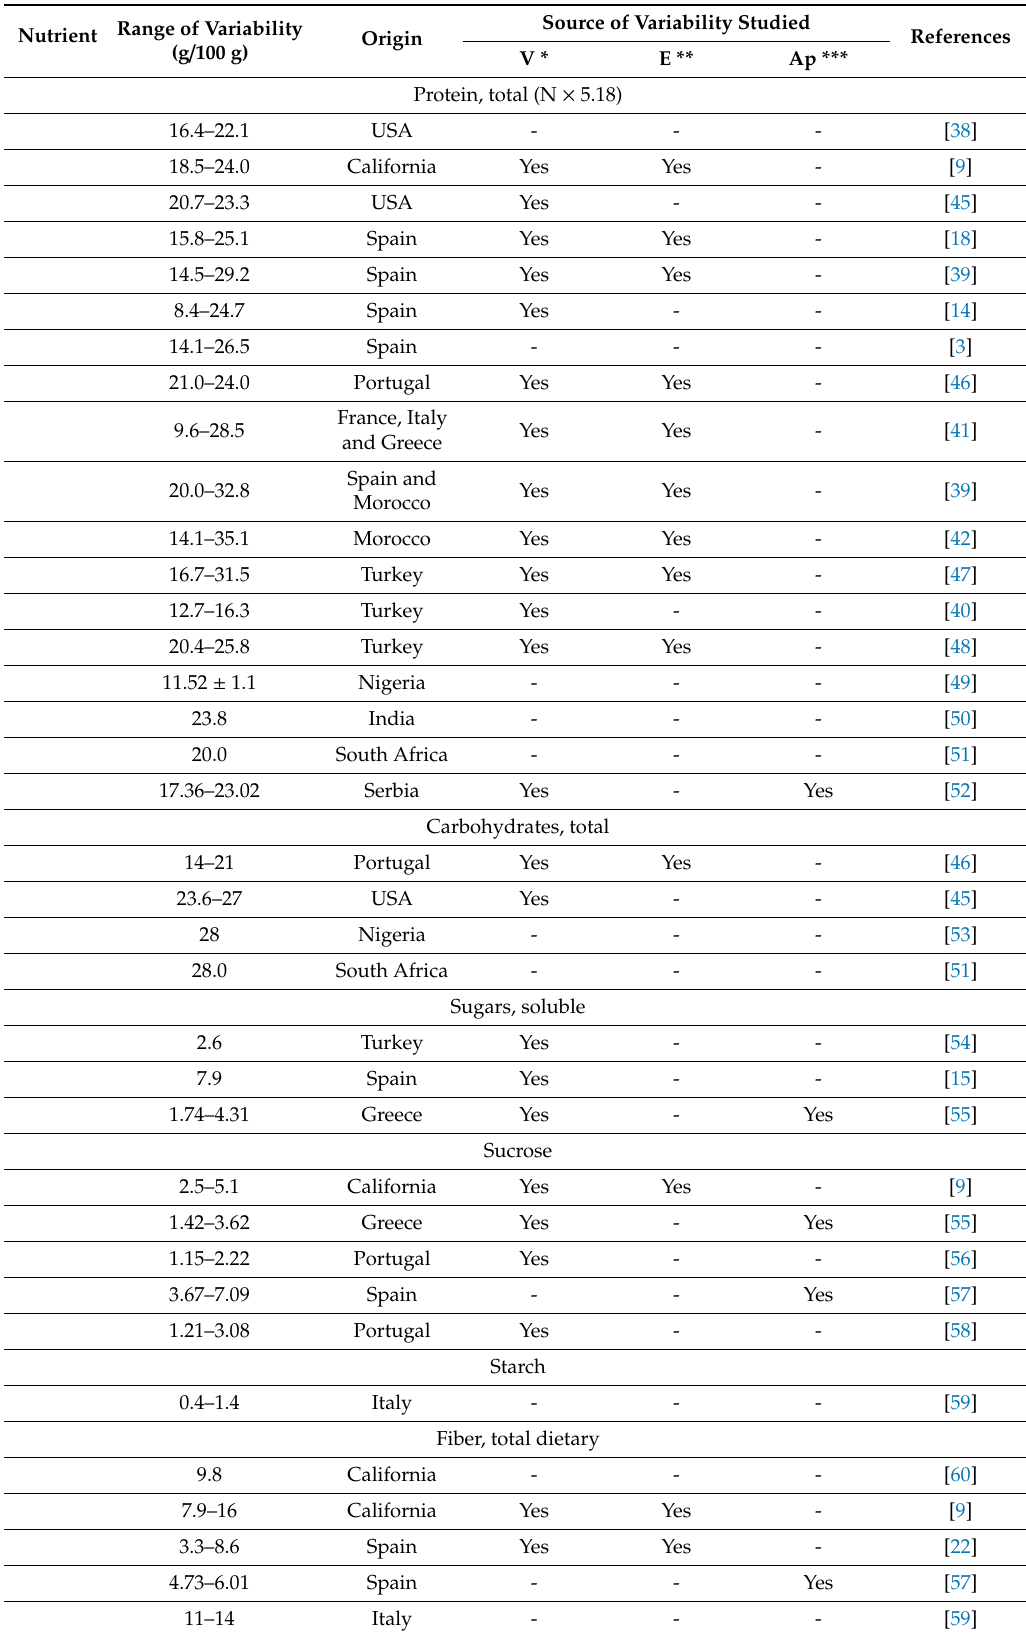
Table 1. Macronutrients content (%) of almond samples with di ff erent